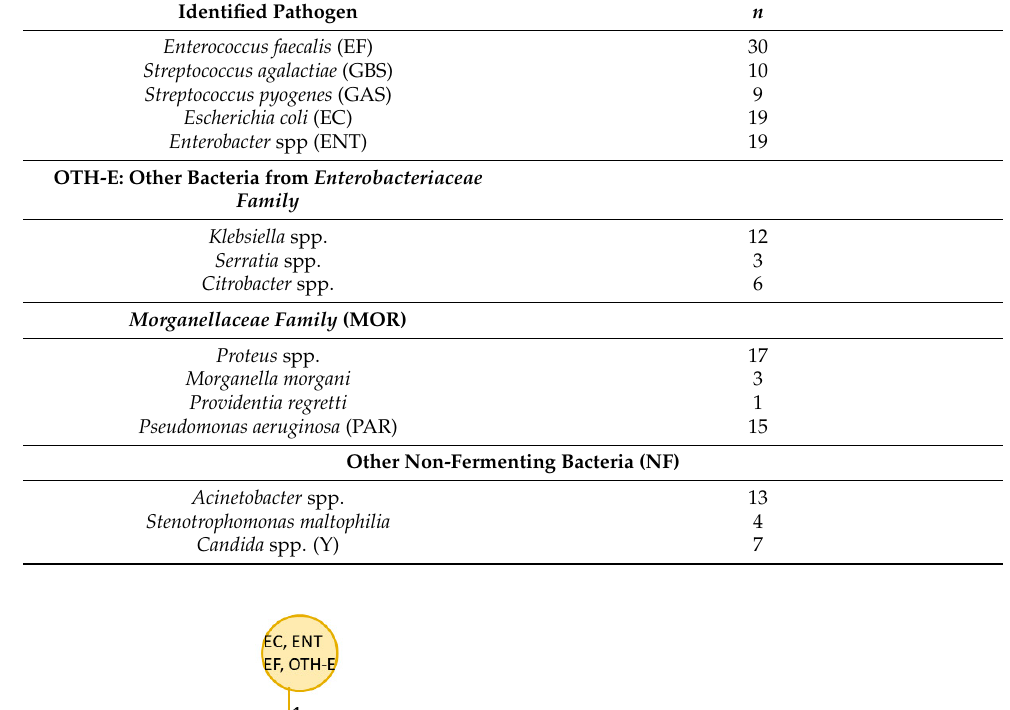
Table 1. Other isolated pathogens.